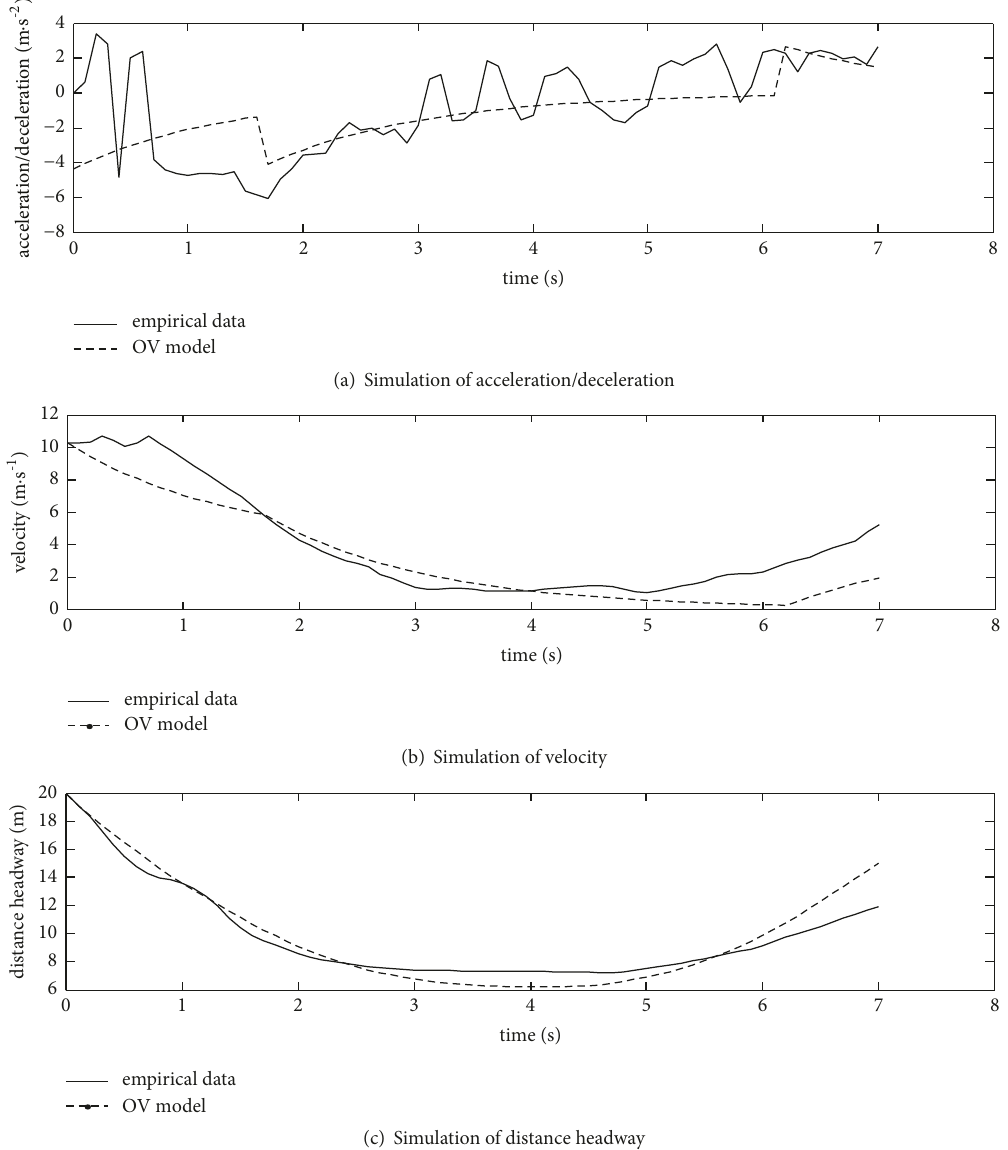
Figure 3: OV model simulations of car-following Process